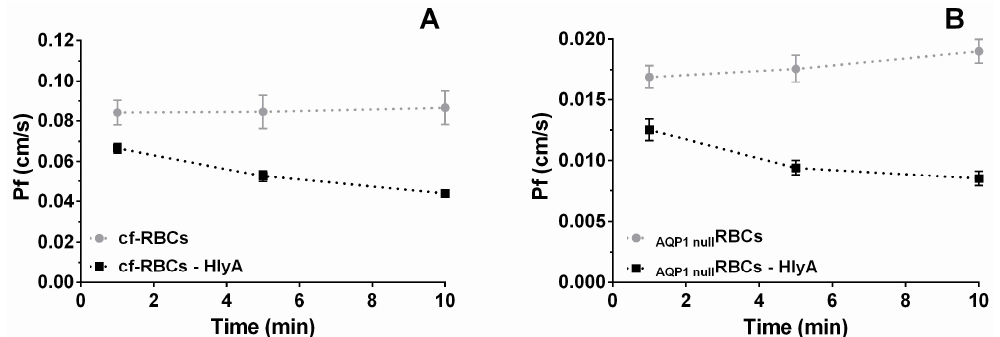
Figure 5. P f as a function of pre-incubation time with HlyA for control RBCs from frozen samples (cf-RBCs) or AQP1null RBCs. The plots show the P f obtained from cf-RBCs (normal RBCs expressing AQP1 that were subjected to the same freeze and thaw procedure as AQP1null RBCs) ( A ) or from AQP1null RBCs ( B ). Suspensions of RBCs at 10% of hematocrit were pre-treated with 100 ng/mL HlyA (black squares) or without toxin (gray circles) for 1, 5 or 10 min at 37 °C. Then, stopped-flow experiments were performed as indicated in Section 4.7. P f was calculated as indicated in Section 4.8. Control experiments were run in the absence of toxin (Control and HlyA conditions on both cf-RBCs and AQP1null RBCs, n = 3). Data are means ± S.E.M.